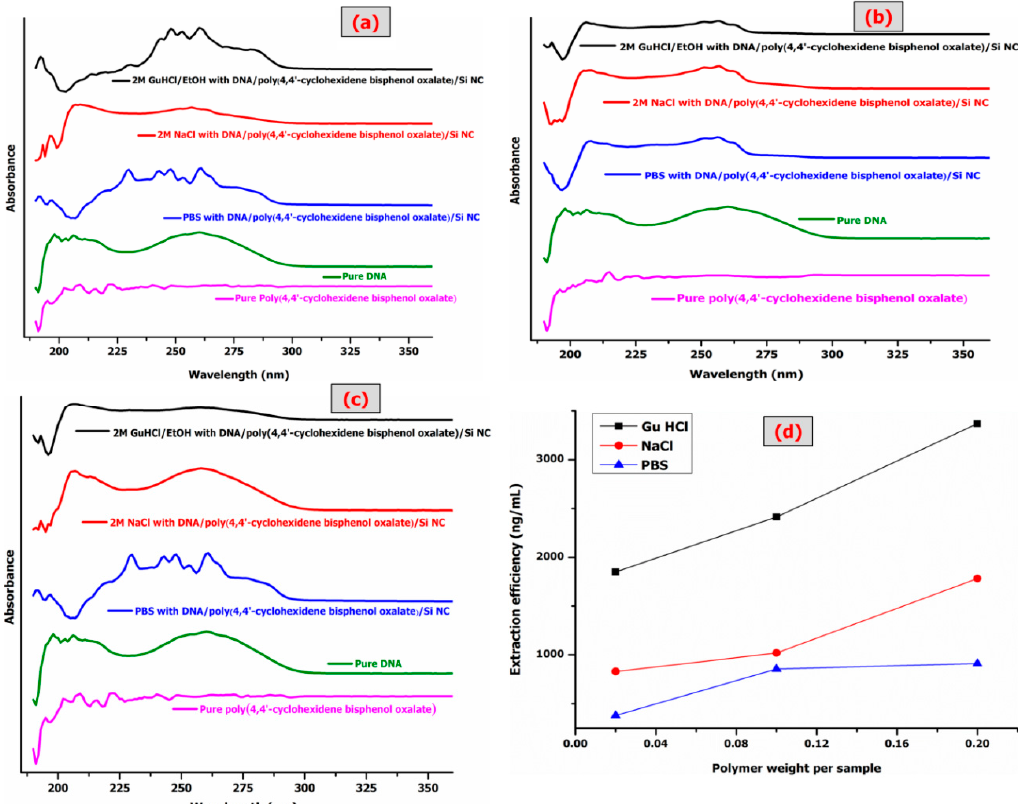
Figure 8. UV-Vis spectral comparison of DNA bonded with ( a ) 0.2 g of poly(4,4’-cyclohexylidene bisphenol oxalate)/Si(13%) NC, pure poly(4,4’-cyclohexylidene bisphenol oxalate), and pure DNA; ( b ) 0.1 g of poly(4,4’-cyclohexylidene bisphenol oxalate)/Si(13%) NC; ( c ) 0.02 g of poly(4,4’-cyclohexylidene bisphenol oxalate)/Si(13%) NC; and ( d ) shows a comparison of DNA extraction efficiency against changes in the weights of polymer (0.02 g, 0.1 g, and 0.2 g) and binding buffer solutions (GuHCl/96% EtOH, PBS, and Table 6. Extraction efficiencies and total yields of DNA for the poly(4,4’-cyclohexylidene bisphenol oxalate)/Si (13%) NC when tested under different weights and binding buffers.